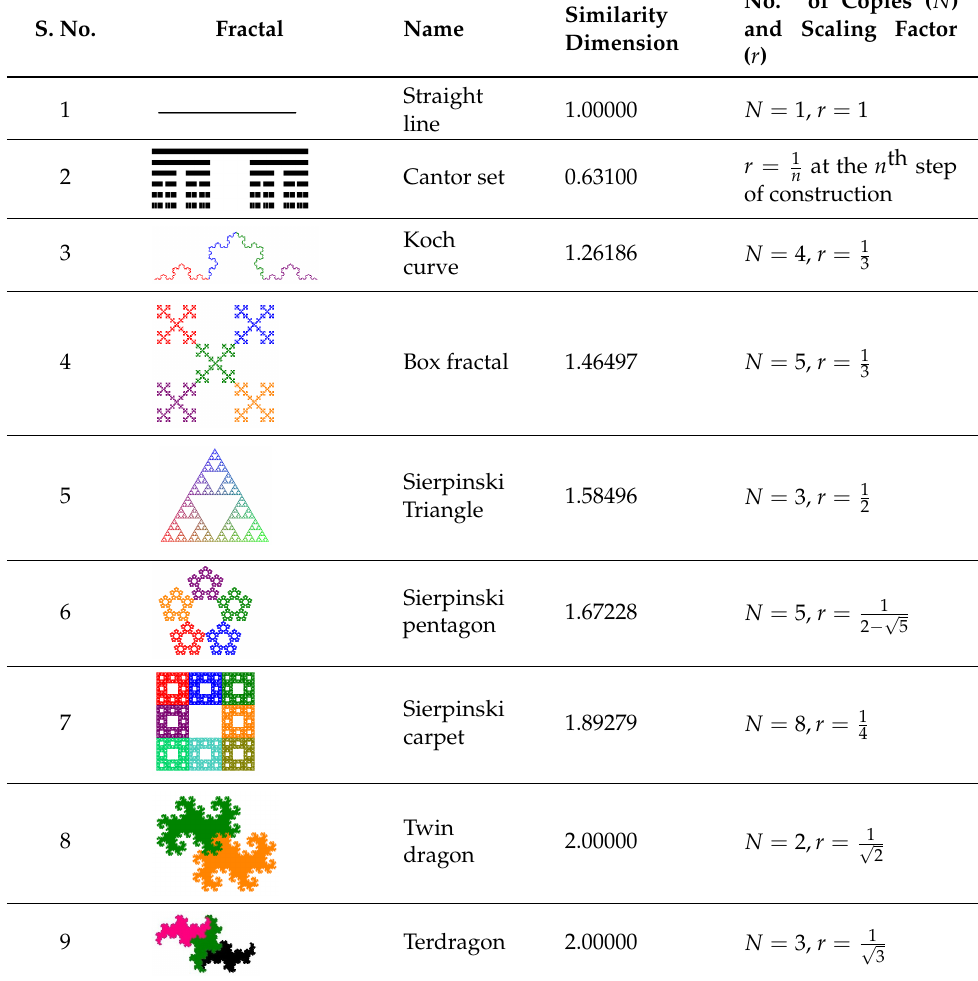
Table 1. Similarity dimensions of some well-known